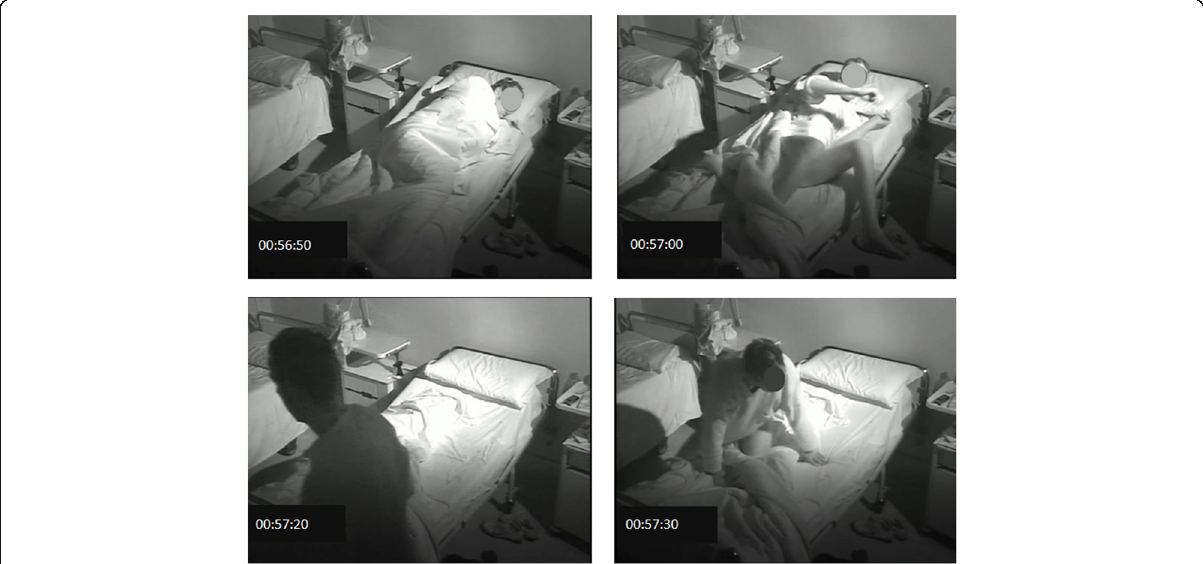
Fig. 7 Photographic sequences of Complex Arousal with Ambulatory Movements (CAMs) or Sleepwalking. The patient is sleeping on his left side (00:56:50), gets up, starts walking, and finally turns in bed